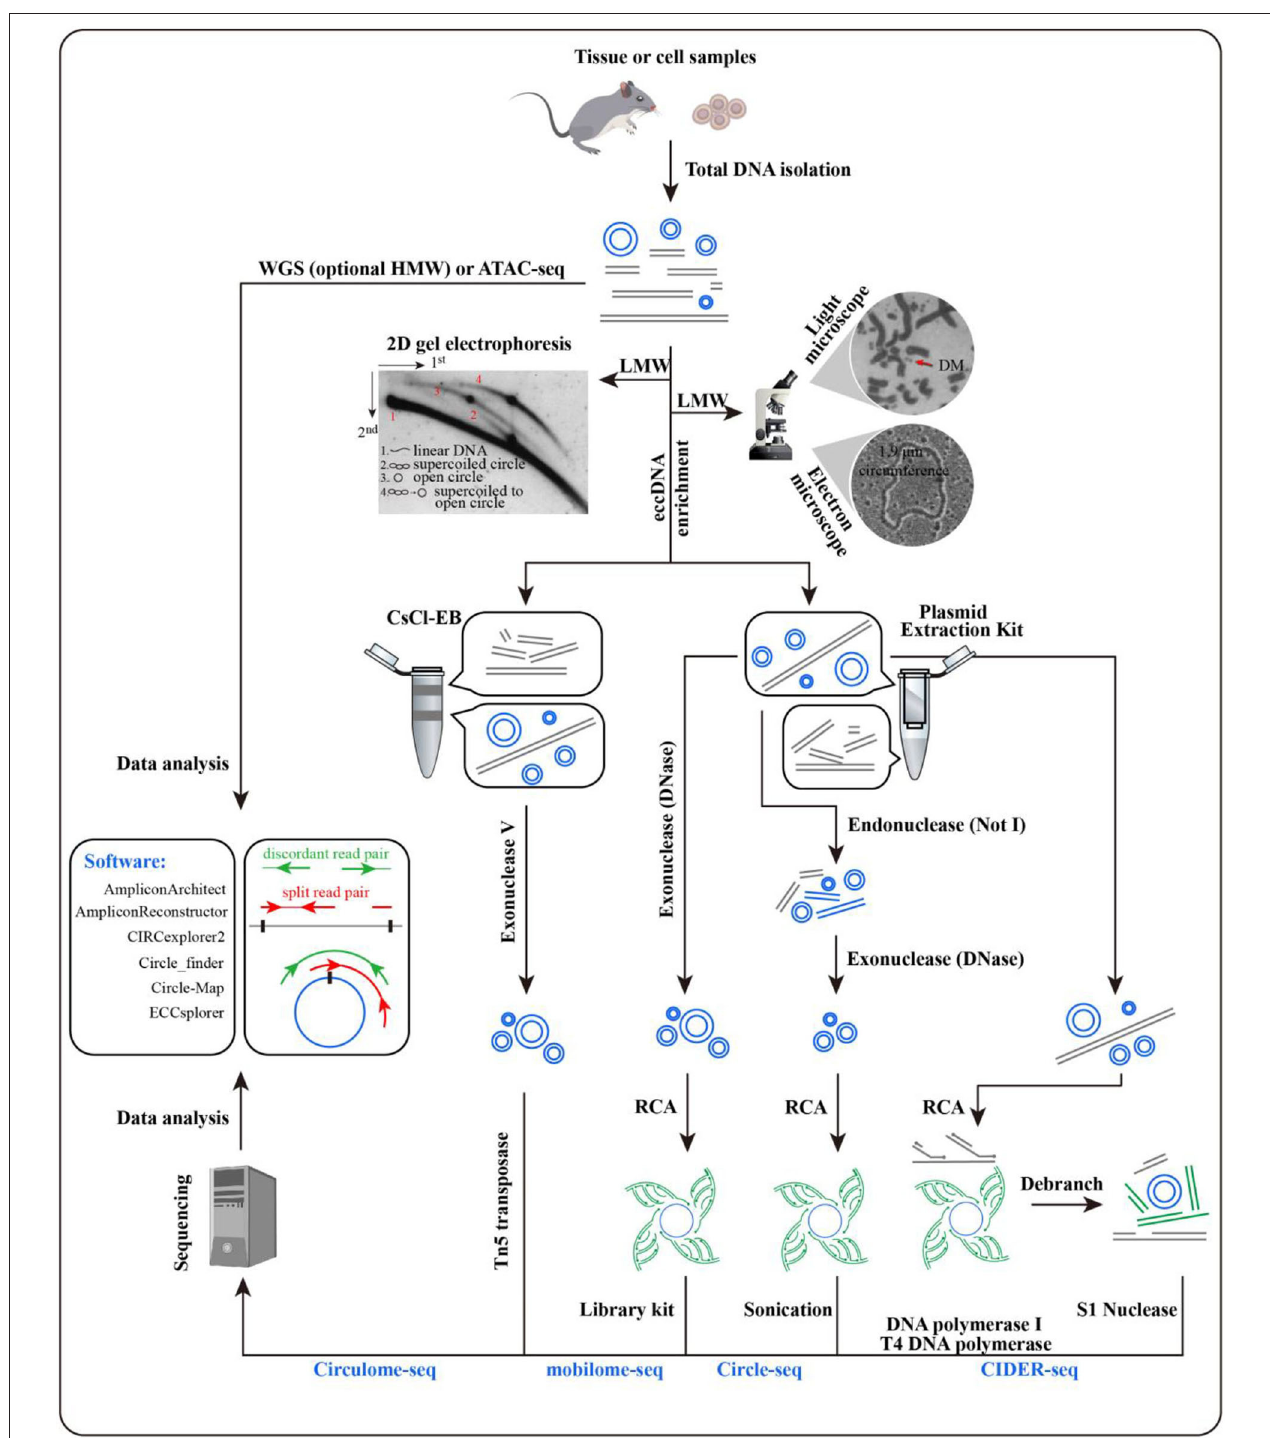
FIGURE 3 | Methods for extrachromosomal circular DNA (eccDNA) identification. Microscopy and electrophoresis are used for eccDNA detection in total DNA after the enrichment of low-molecular-weight DNA [pictures were from Radloff et al. (8), Hahn (53), and Cohen et al. (54)]. Before rolling circle amplification or Tn5 treatment, eccDNAs with target size are enriched by CsCl-EB or a plasmid extraction kit. Split and discordant read pairs are crucial for eccDNA detection, which makes WGS and ATAC-seq data available as well. Various software packages have been developed to call eccDNA with sequencing data, including AmpliconArchitect, AmpliconReconstructor, CIRCexplorer2, Circle_finder, Circle-Map, and ECCsplorer (32, 55–59). Comparisons have been made for some of these packages, and detailed information can be found in Prada-Luengo et al. (57).